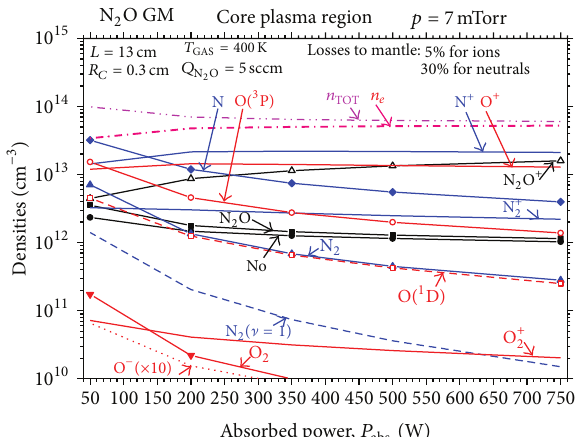
Argon: dashed lines N 2 O/N/O: plain lines Figure 12: Comparison of the variations of the 𝑇 𝑒 , partial and total ionization percentage for the “core” region of a N 2 O fed, and of an Ar fed HPT, as a function of absorbed power for 7